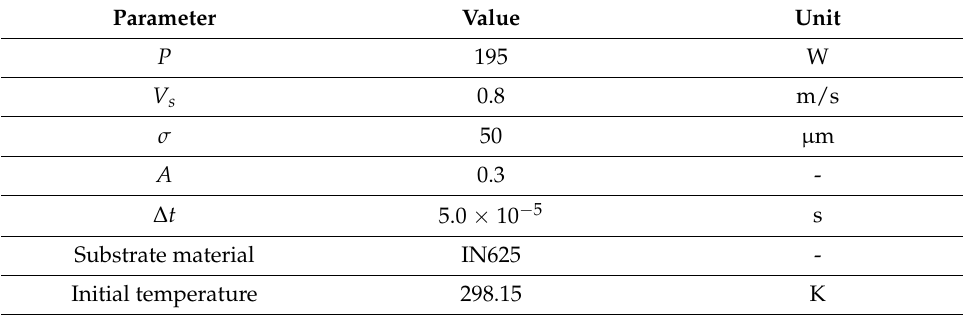
Table 2. Process and material parameters used in the current simulation